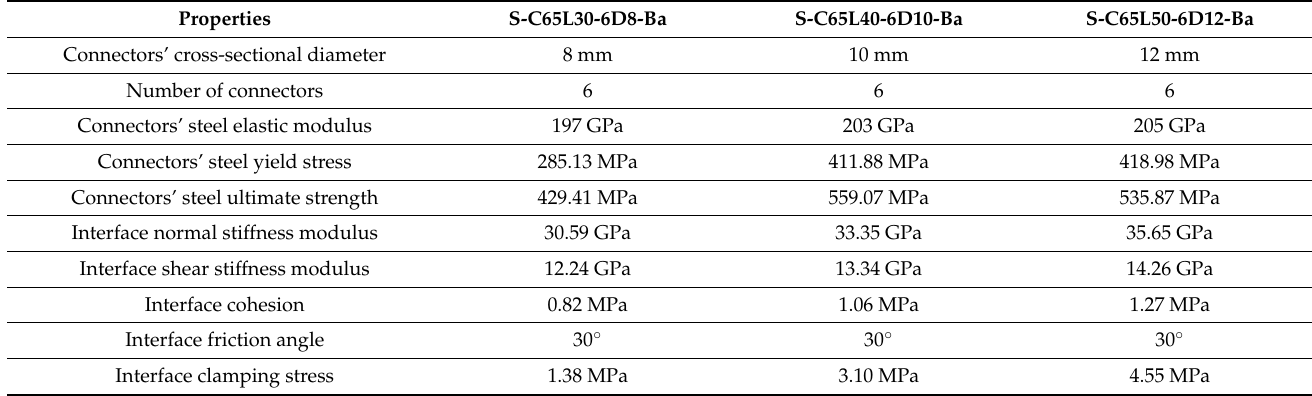
Table 2. Connectors and interface characteristics for numerical models.